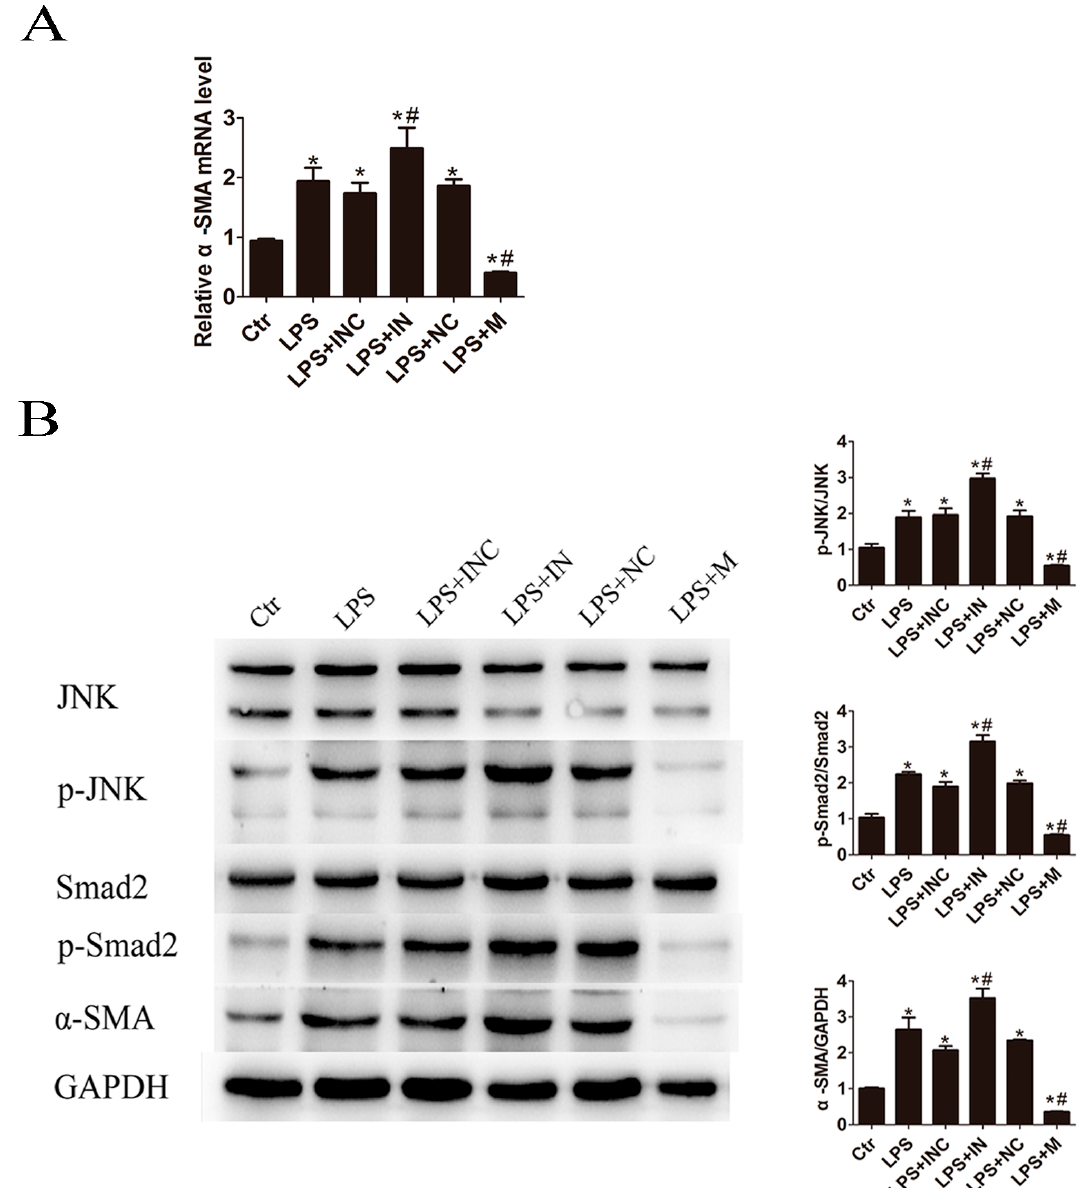
Figure 5. miR-146a-5p mimic attenuated LPS induced JNK activation and α -SMA expression. After pretreatment in the absence or presence of miR-146a-5p for 24 h, LX2 cells were stimulated with 500 ng/mL of LPS for 24 h: ( A ) Overexpression of miR-146a-5p significantly inhibited α -SMA mRNA expression; and ( B ) Western bolt showed that miR-146a-5p mimic significantly decreased LPS induced p-JNK, p-Smad2 and α -SMA expression while miR-146a-5p inhibitor showed the contrary changes. * p < 0.05 vs. blank control group; # p < 0.05 vs. the corresponding negative control group. Ctr: blank control; INC: miR-146a-5p inhibitor control; IN: miR-146a-5p inhibitor; NC: miR-146a-5p mimic control; M: miR-146a-5p mimic.